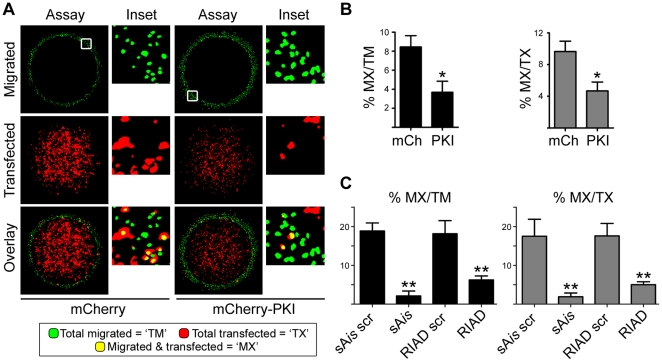
PKA activity and anchoring are required for SKOV-3 cell migration.(A) SKOV-3 cells were transfected with either empty mCherry plasmid or mCherry-PKI, then subject to donut migration assays. Representative thresholded images of the migrated cells (Migrated, with nuclei pseudocolored green), the total population of transfected cells (Transfected), and an overlay of these two images are shown. Insets depict enlargements of the areas indicated by the squares in the top panels. Thus, the total migrated cells (‘TM’) are depicted in green, the total transfected cells (‘TX’) are depicted in red, and the yellow nuclei depict transfected cells that migrated, i.e. migrated and transfected cells (‘MX’). (B) For cells transfected with either empty mCherry (mCh) or mCherry-PKI (PKI), the average percent (± S.E.) of migrated transfected cells over the total number of migrated cells (‘MX/TM’) was calculated. To normalize for transfection efficiency, average percent (± S.E.) of migrated transfected cells over the total number of transfected cells (‘MX/TX’) was also calculated. (* = P<0.05) (C) SKOV-3 cells were transfected with plasmids encoding EGFP fused to inhibitors of type-I (RIAD) or type-II (sAis) PKA anchoring, or their respective scrambled controls (RIAD scr, sAis scr), then subject to donut migration assays and analysis as described in (A and B). (** = P<0.001)